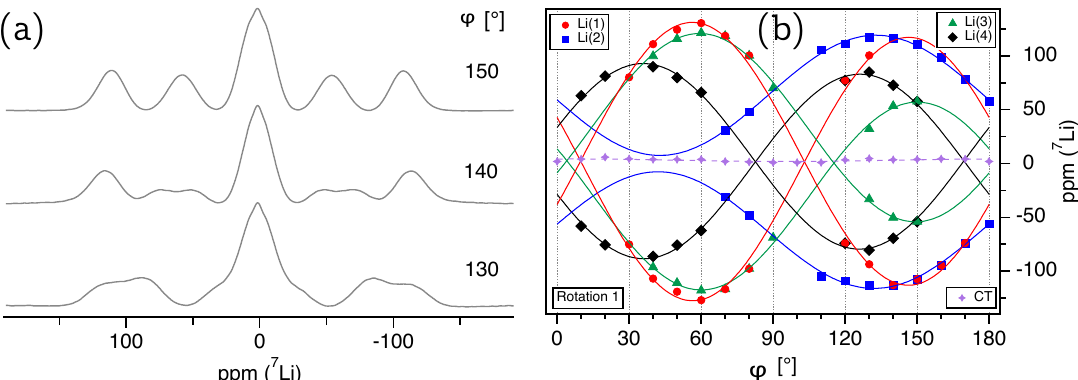
Figure 4. (a) Single crystal of aluminum nitride, AlN, from Leibniz Institute for Crystal Growth (IKZ, Figure 5. ( a ) 7 Li NMR spectra of the LDP single crystal, with the indicated rotation angles ϕ referring Berlin), with the crystallographic c axis and ab plane indicated by arrows.[10] (b) Wurtzite structure to the full rotation pattern on the right. ( b ) Full rotation pattern over 180 o for the four magnetically of AlN, according to Reference [9], viewed down the crystallographic (11-20) direction. The aluminum inequivalent 7 Li at Wyckoff position 4 a , acquired by rotating the LDP crystal counter-clockwise by 10 o atoms (grey) and the nitrogen atoms (yellow), both located at Wyckoff position 2 b , are tetrahedrally around the goniometer axis (cid:126) g 1 . The lines represent the fit of the experimental points to the quadrupole coordinated by each other with one Al-N bond directed parallel to the crystallographic c axis. (c) Individual, coupling tensor elements and axis orientation (see text for details). tetrahedrally coordinated, aluminum and nitrogen atom in the crystal structure of AlN, in which the three equal, shorter, bonds Al/N—I/II/III [1.8891(8) Å] and the longer bond Al/N—IV [1.9029(16) Å] along the three-fold rotation axis are highlighted. a Drawing generated with the Vesta program [11].